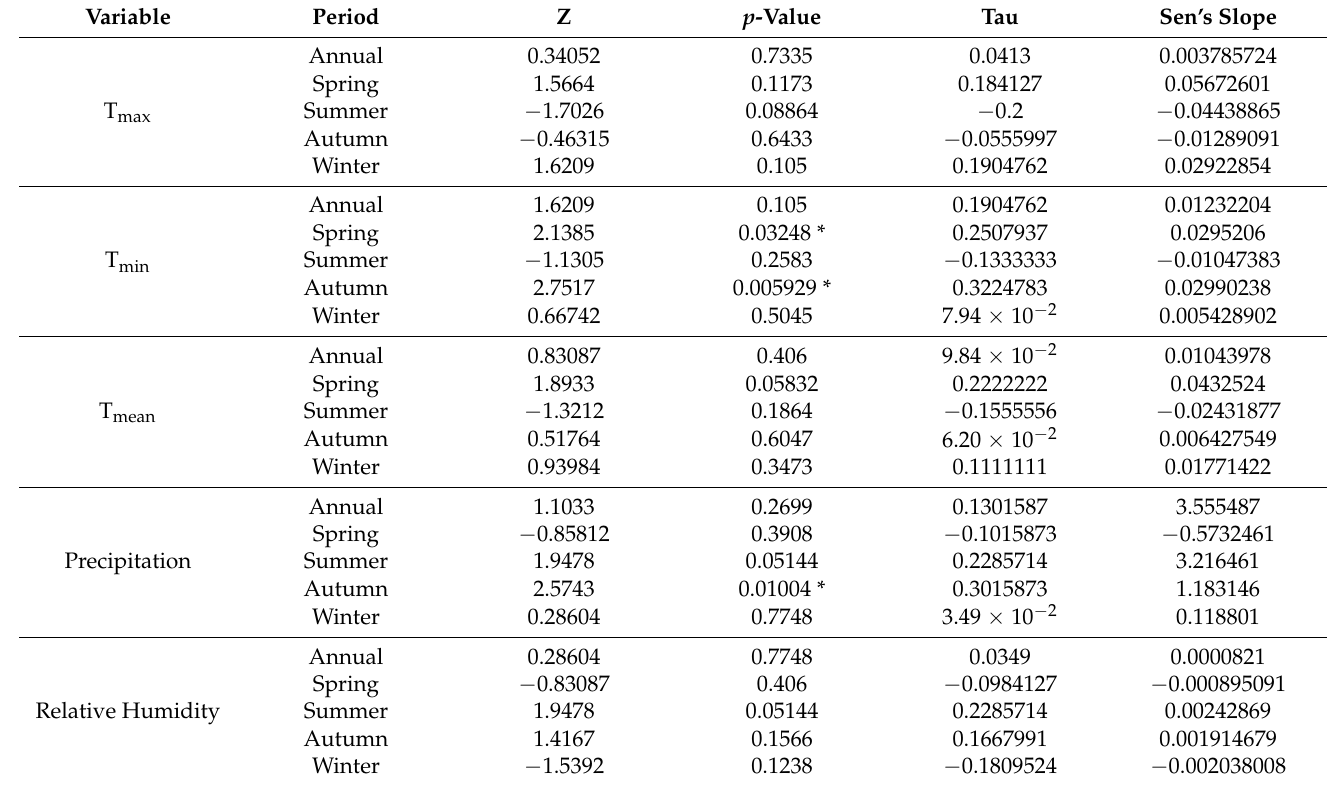
Table 6. Summary of the results showing significant increasing and decreasing trends in the annual and seasonal datasets using the Mann–Kendall (MK) test on 1979–2014